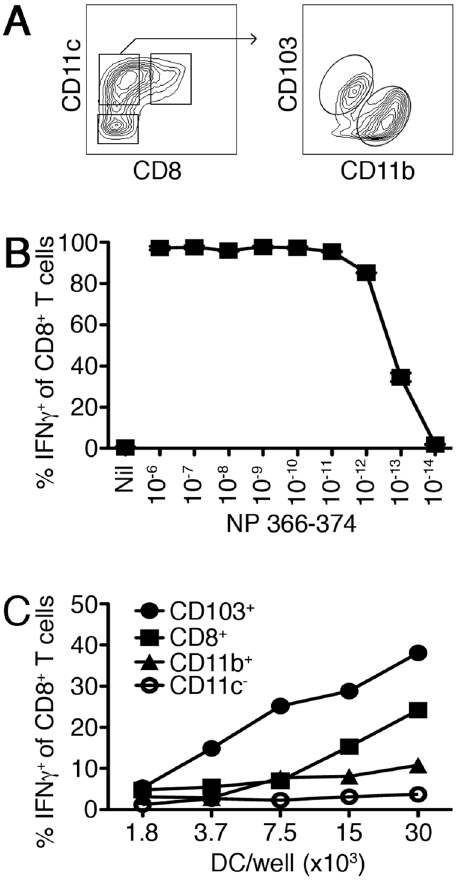
Figure 3. Antigen presentation by DC subsets after influenza infection. B6 mice were inoculated with PR8 and 3 days post infection the lung draining mediastinal lymph nodes were pooled and DC isolated. (A) Gating strategy for isolation of enriched DC subpopula- tions: CD8 + DC were purified on the basis of expression of CD11c and CD8 (upper left; right gate); CD11c + CD8 2 cells (upper left; left gate) were segregated into CD103 + CD11b 2 (upper right; top gate) and CD103 2 CD11b + (upper right; lower gate); and finally CD11c 2 cells were isolated (upper left; bottom gate). (B) The antigen-specific T cell activation for the T cell line specific for the H-2D b restricted influenza epitope NP 366–374 was assessed using B6 bone-marrow derived DCs pulsed with NP 366–374 peptide at indicated dilutions in a standard ICS assay for IFN c . (C) Production of IFN c by NP 366–374 T cells (5 6 10 4 ) co- cultured for 6 hours with serially diluted DC subsets as identified in (A). Data are representative of two independent experiments, which showed a similar